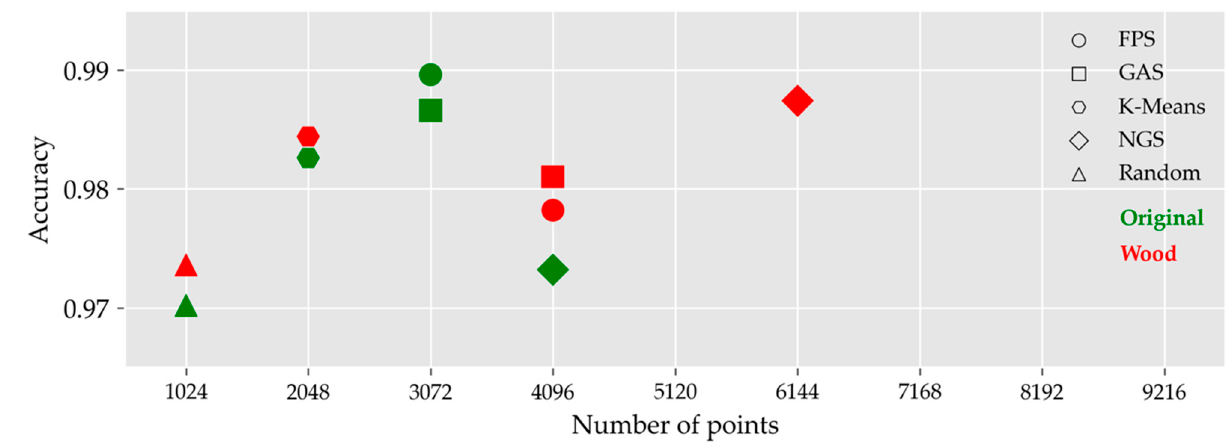
Figure 10. The number of sampling points used for each downsampling method to achieve a maximum classification accuracy of tree species.